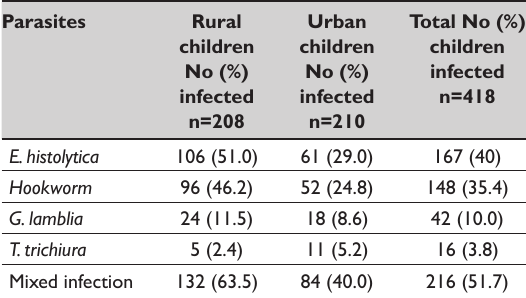
Table 1: Prevalence of intestinal parasites among